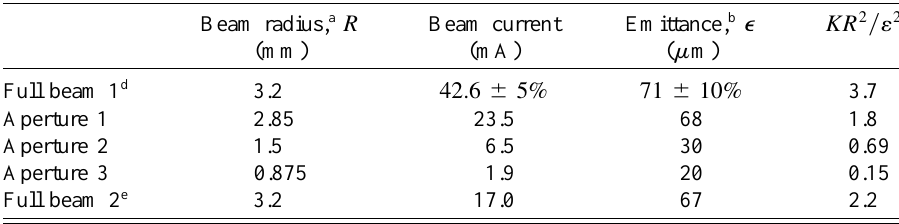
TABLE I. Beam parameters in solenoid